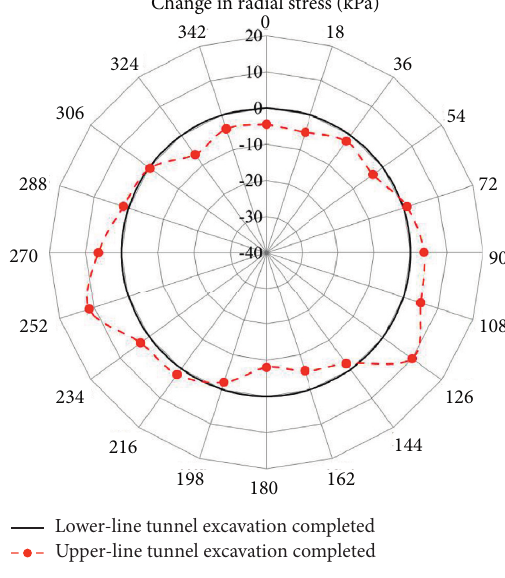
Figure 12: Change in the radial